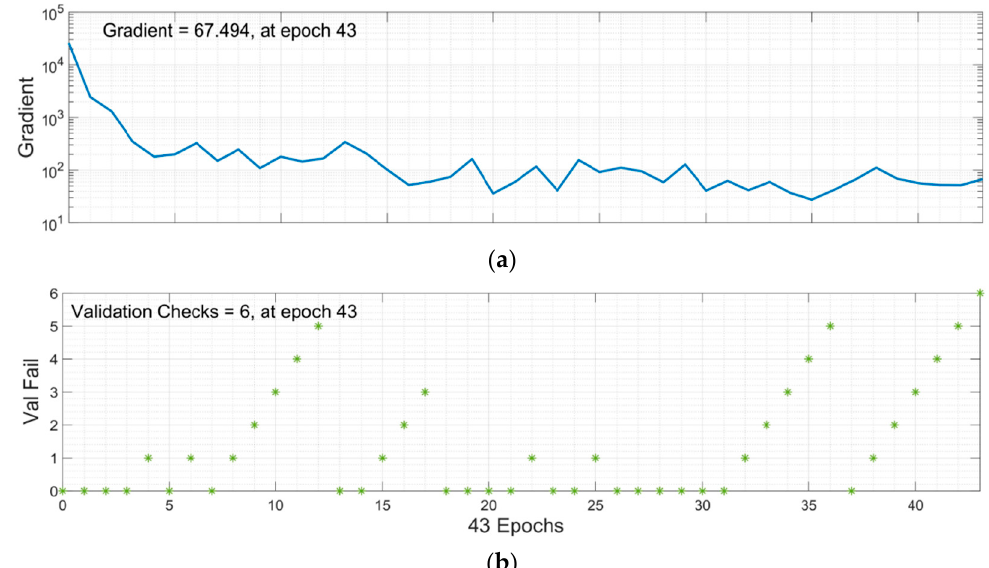
Figure 17. Training State of SCG Algorithm: ( a ) Gradient graph at epoch 43; ( b ) Validation checks graph at epoch 43.